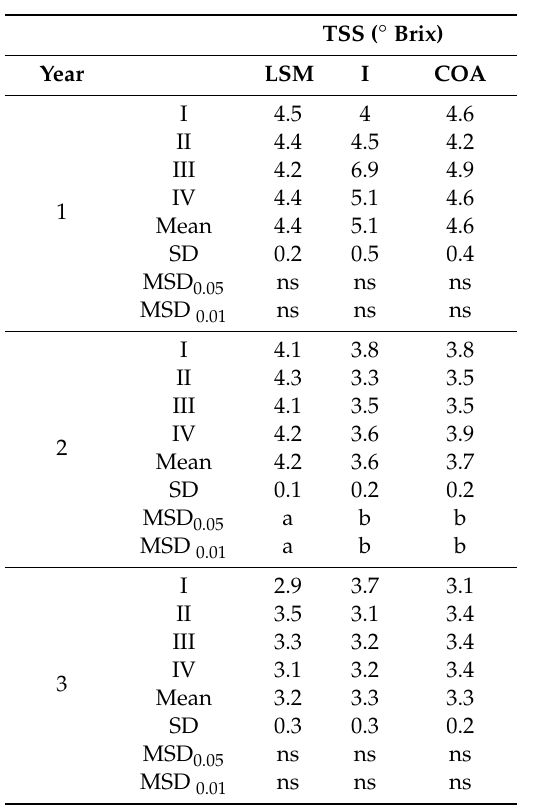
Table 8. The total soluble solids (TSS) content during three cycles of celery crops grown in the field, as a function of the fertilization treatment: local sheep manure (LSM), mineral (I), and commercial organic amendment (COA).